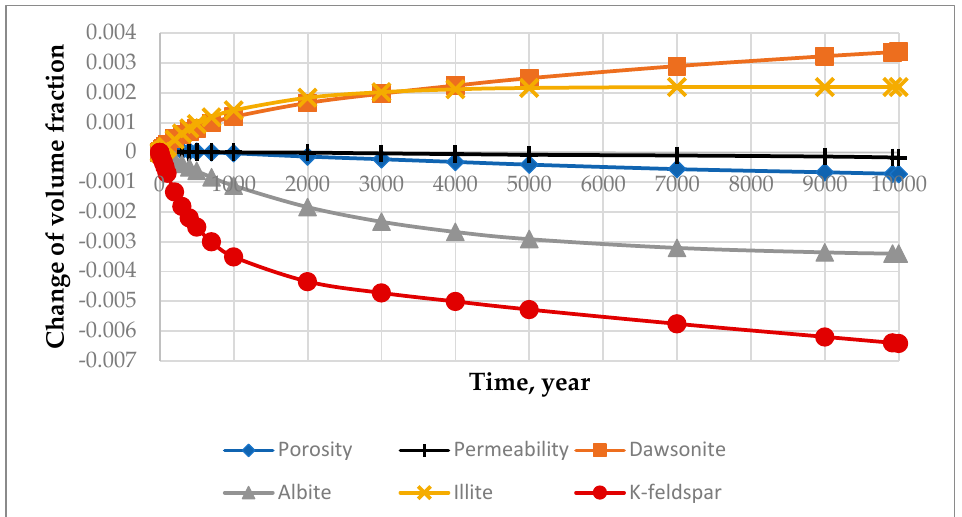
Figure A9. Change in volume fraction of different minerals in the base case along with porosity and permeability alteration near the injection well in the arkosic layer throughout the 10,000 years of simulation. Change in permeability is in Darcy.